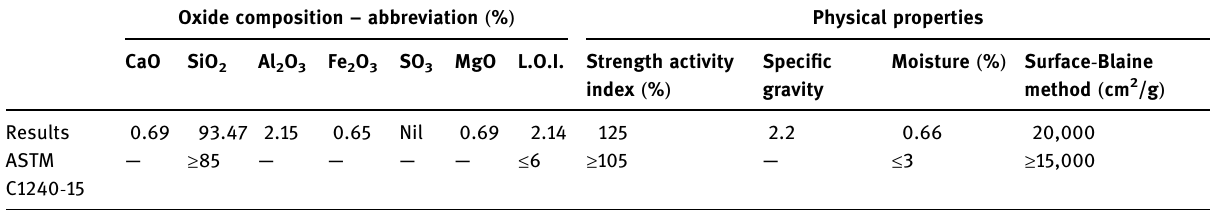
Table 5: Properties of MS